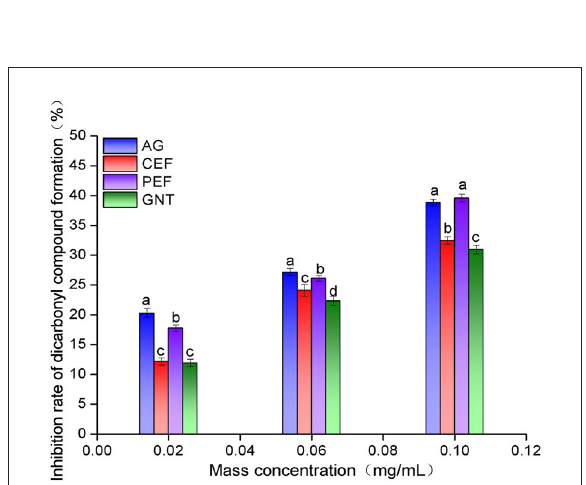
FIGURE13 Intermediate dicarbonyl compounds inhibition rate of CEF, PEF, and GNT at different concentrations. Different lowercase letters represents significant differences within each group at the same concentration ( p < 0.05).